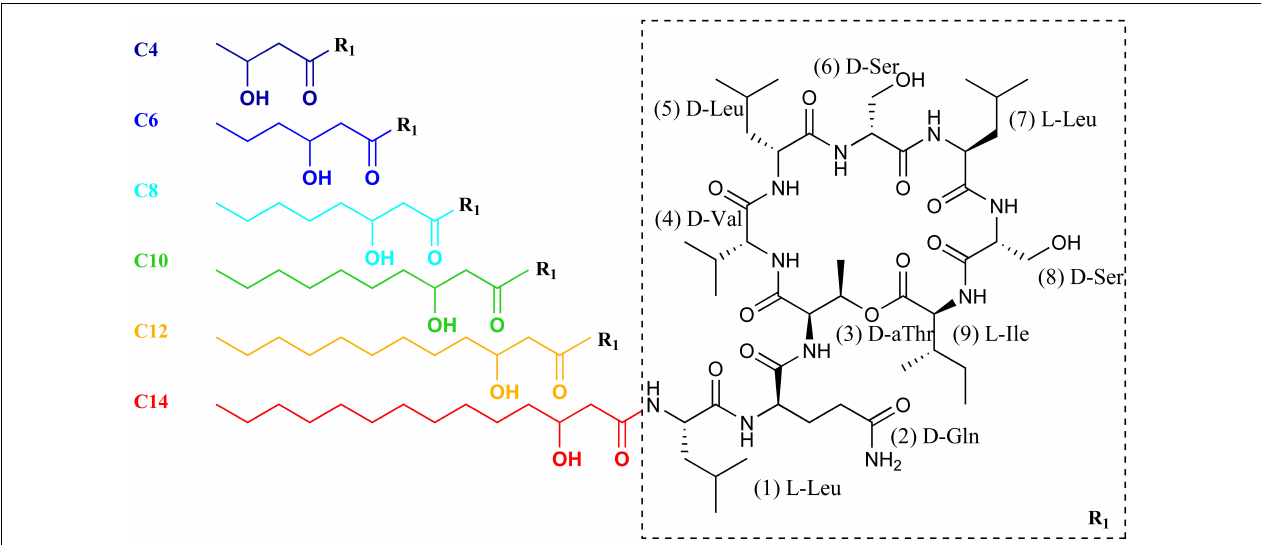
FIGURE 1 | Molecular structure of the pseudodesmin A analogs PSD-C4 to PSD-C14. The color code of each 3-hydroxy fatty acid chain indicates the respective analog (C4–C14) throughout the